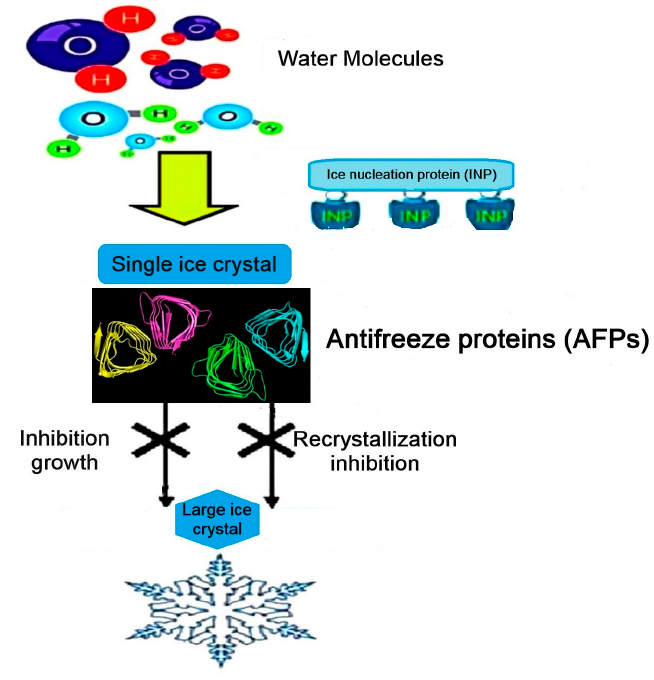
Figure 2. Ice recrystallization inhibition function of AFPs